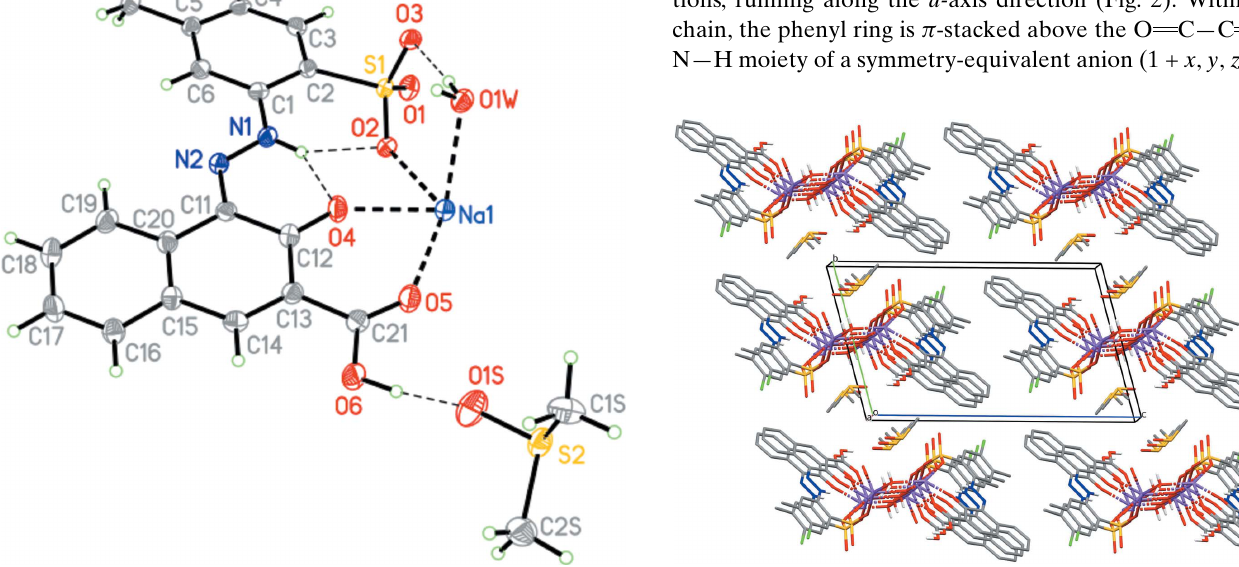
Figure 2 Packing diagram viewed approximately along [100].